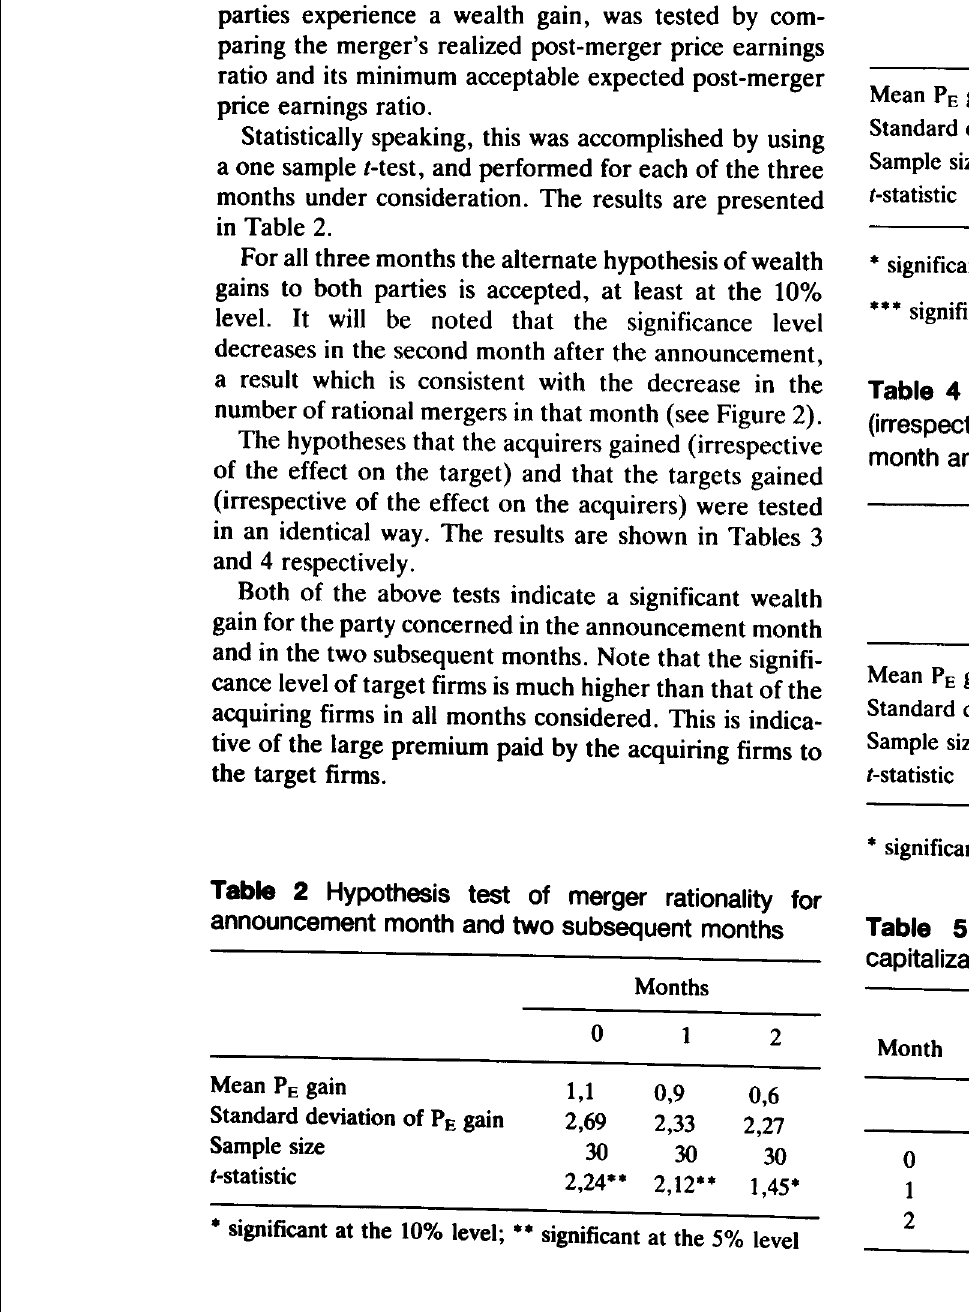
Table 5 Results of linear regression of